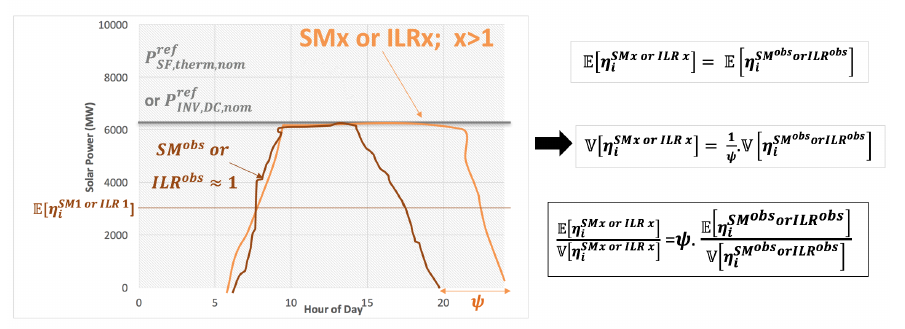
Figure A2. Relationships between CSP (resp., PV) mean capacity factors, variance, CSP Solar Multiple SM (resp., PV Inverter Loading Ratio ILR) and the amount of TES (resp., BES). Different cases are represented to illustrate the effect of the bias correction. ( a ) Assuming the case ( i ) where the SF (resp., SP) increases without increasing the amount of storage, the mean CFs will increase and the variance will increase even more (the CF variances tend to scale quadratically with CF means) which tend to reduce the ratio CF/variance with the increasing of SM (resp., ILR). Assuming the case ( ii ) where the SF (resp., SP) increases with increasing the amount of storage, the mean CFs will increase and the variance will increase but will be reduced by ψ which tend to increase slightly the ratio CF/variance with the increase of SM (resp., ILR) compared to case (i). Since the bias correction ( b ) is bringing the mean of the CFs roughly equal to the CFs of the observed SM (resp., ILR) ( iii ). In this case, the variance will decrease (i.e., the ratio CF/variance will increase) with the increase of SM (resp., ILR) due to the reduction in the variability associated with storage.